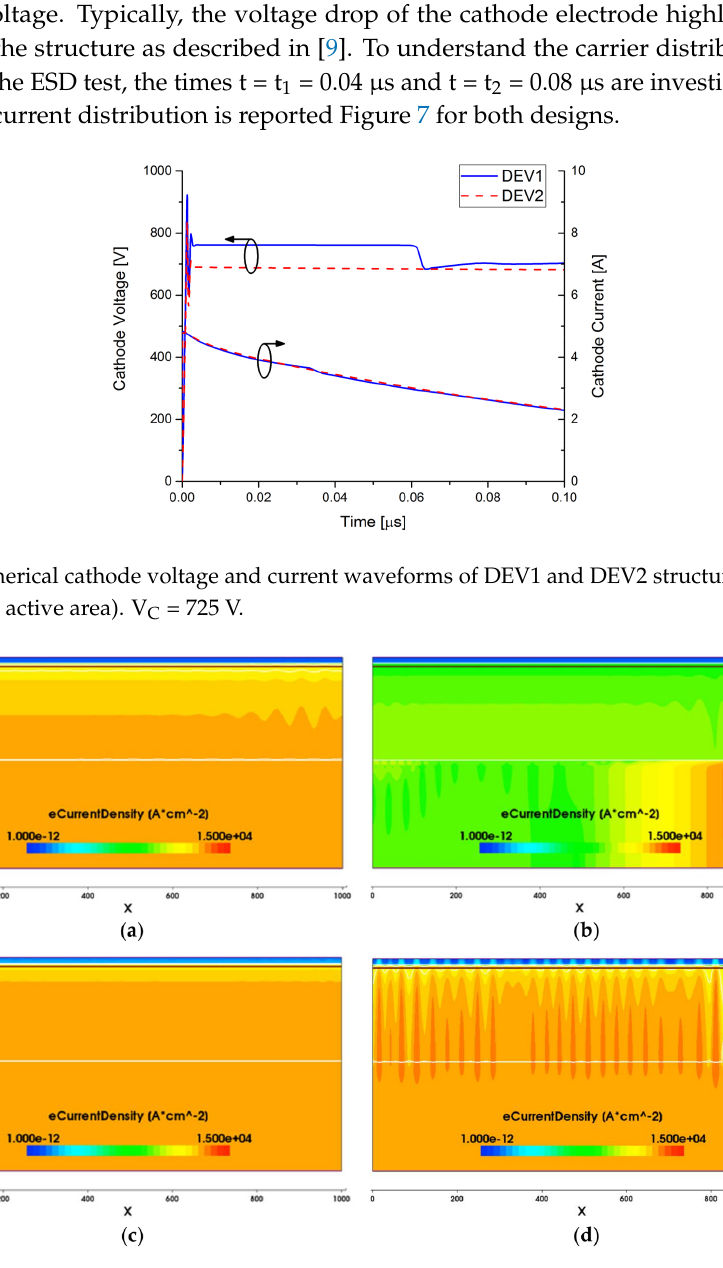
Figure 7. Electron current density distribution in the structure DEV1 at: ( a ) t = t 1 ; and ( b ) t = t 2 . Electron current density in the structure DEV2 at ( c ) t = t 1 ; and ( d ) t = t 2